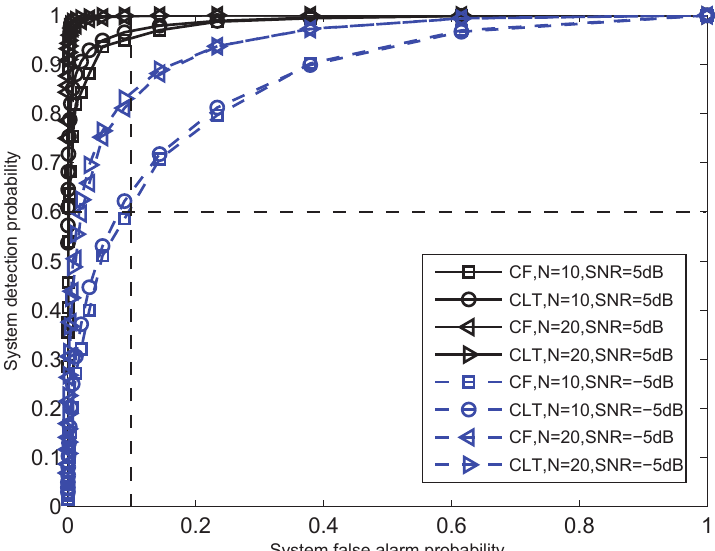
Figure 3. ROC curves for the likelihood ratio test (LRT)-bit error (BER) fusion rule based on central limit theorem (CLT) and closed-form (CF) performance evaluation with N = 10 and N = 20. Average received SNRs are assumed to be SNR = − 5 dB and SNR = 5 dB. Each local detection index is assumed to be equal to each other ( P modulation is used, and the Rayleigh fading envelope is